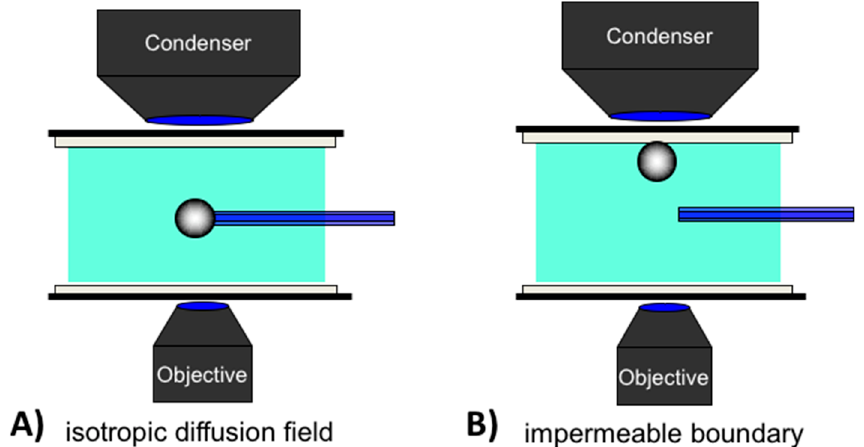
Figure 20. Schematics of pipette and gas microbubble in microchamber. ( A ) Microbubble held in infinite dilution and isotropic diffusion field; ( B ) microbubble allowed to rise to the top of the chamber, also in infinite dilution but now air-diffusion is limited by the impermeable boundary of the wall of the glass microchamber.